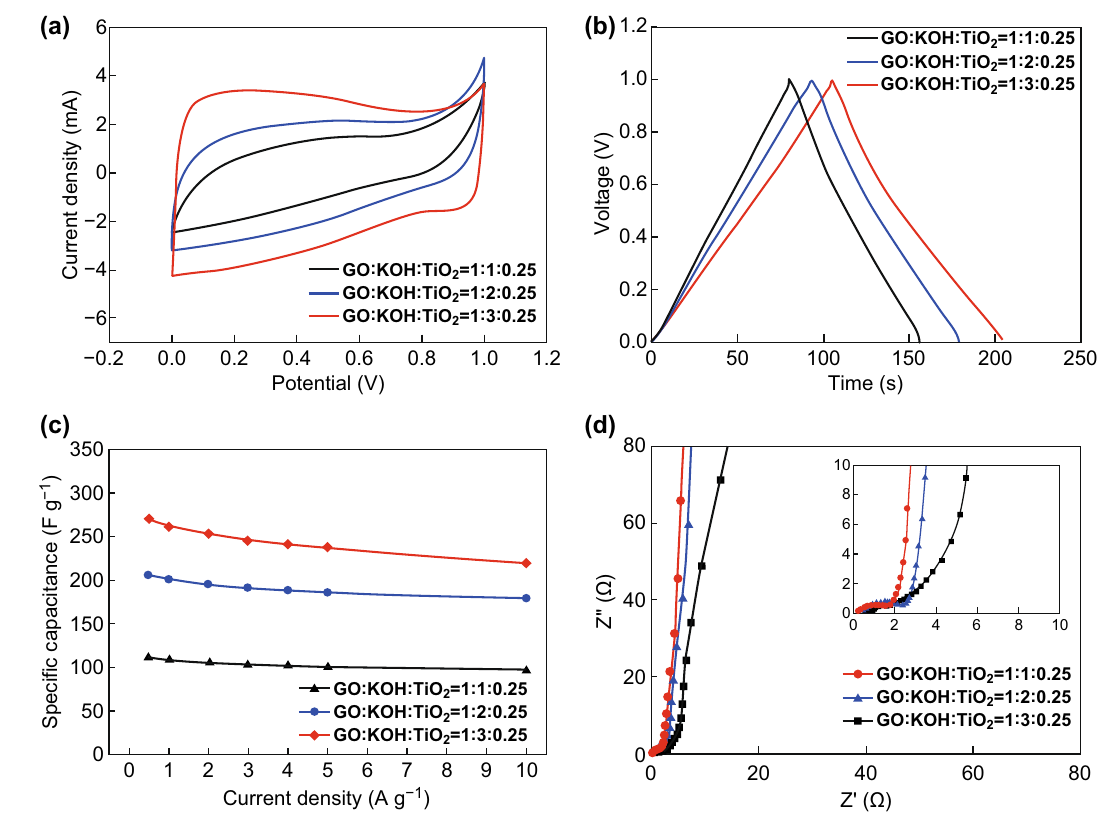
Fig. 6 a CV curves, b GCD curves, c specific capacitances, d EIS curves of the KTO NP/PGC composites prepared at different weight ratios of GO and KOH, measured using a symmetric two‑electrode